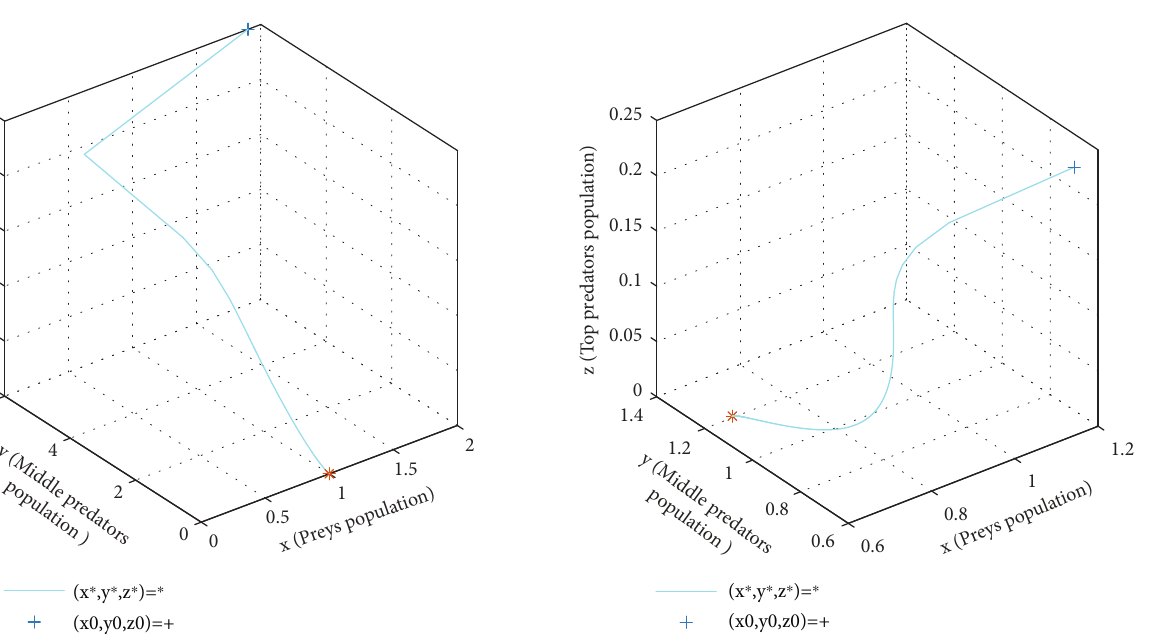
Figure 1: The plot shows the local stability of E